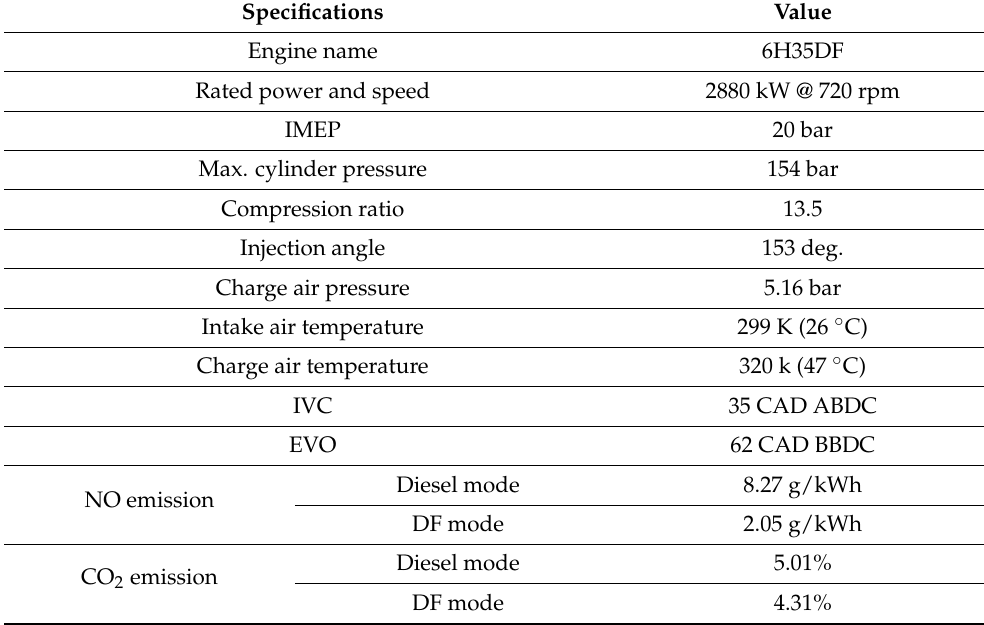
Table 6. Engine specifications and shop test conditions and